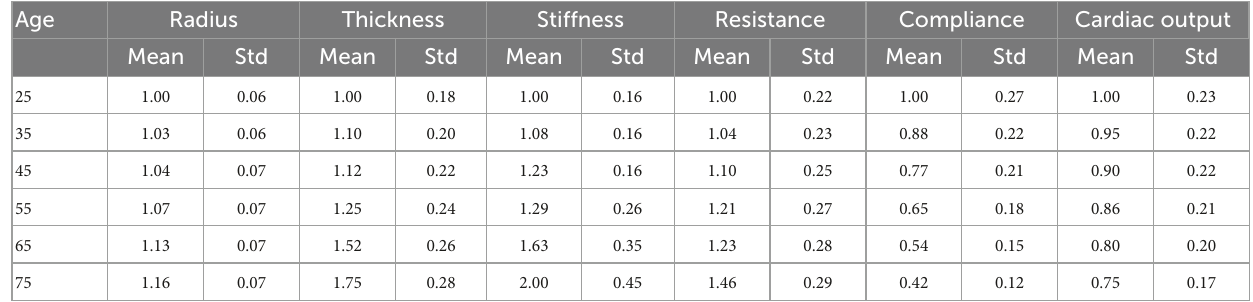
TABLE 1 Distribution of scaling parameters for the ageing model.